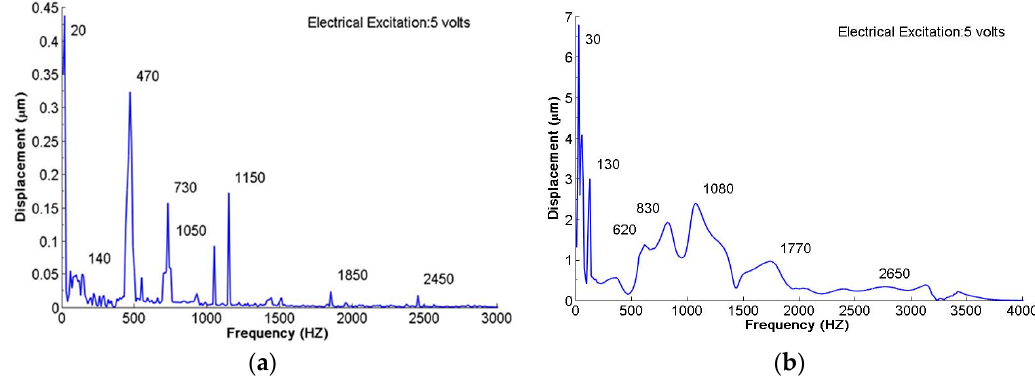
Figure 13. LDV displacement spectrum of glycerine-coupled ( a ) anti-phase vibration and ( b ) in-phase vibration.